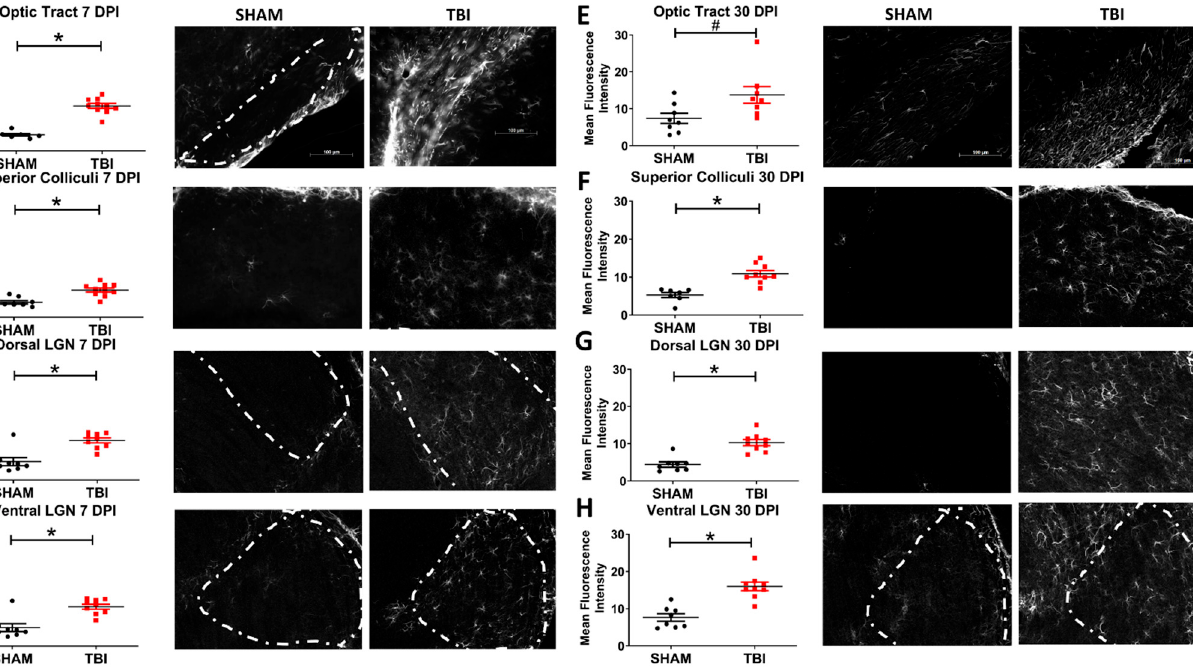
Figure 9. Astrogliosis of the optic system in iTON mice 7 ( A – D ) and 30 ( E – H ) DPI. White dashed lines mark the areas analyzed in sham and iTON mice where it is more difficult to visualize the location of the nuclei. Representative photomicrographs taken at 10× magnification, scale bar 100 μ m. * p ≤ 0.001 and # p <0.05.